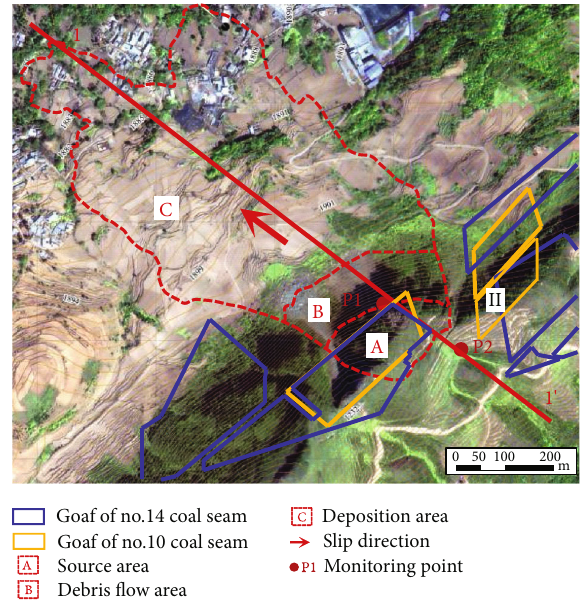
Figure 4: Top view of No. 10 coal seam goaf, monitoring point, and sliding area.